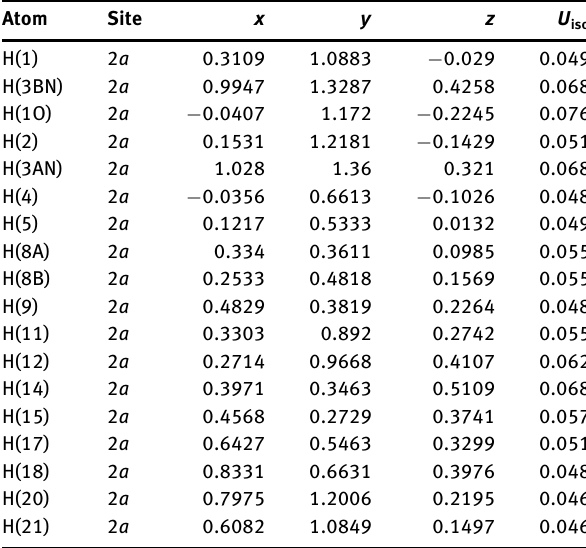
Table 2: Atomic coordinates and displacement parameters (in Å 2